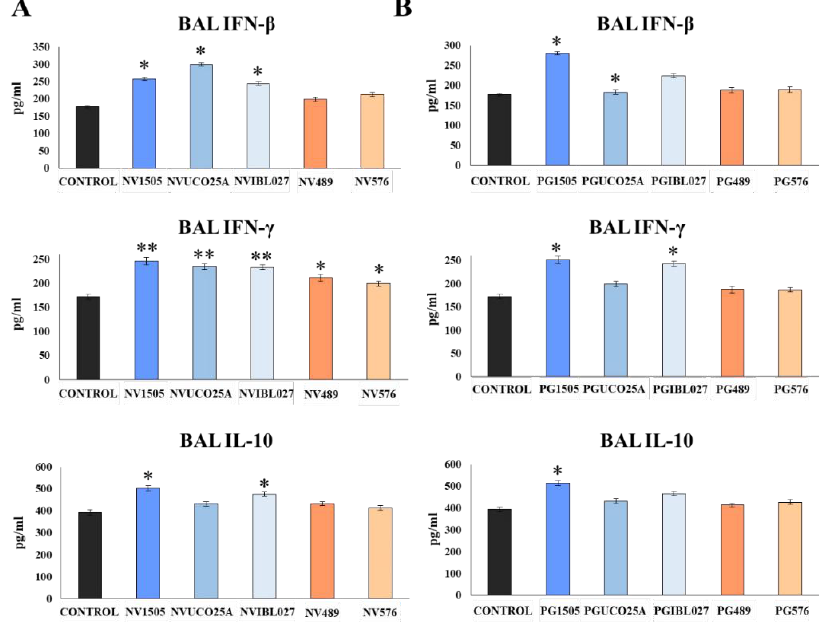
Figure 2. ( A ) Role of interferon (IFN)- β , IFN- γ and interleukin (IL)-10 in the ability of non-viable (NVs) L. rhamnosus CRL1505, CRL498, CRL576, UCO25A and IBL027 and ( B ) their peptidoglycans (PGs) to improve resistance to secondary pneumococcal pneumonia after poly(I:C) treatment. Infant